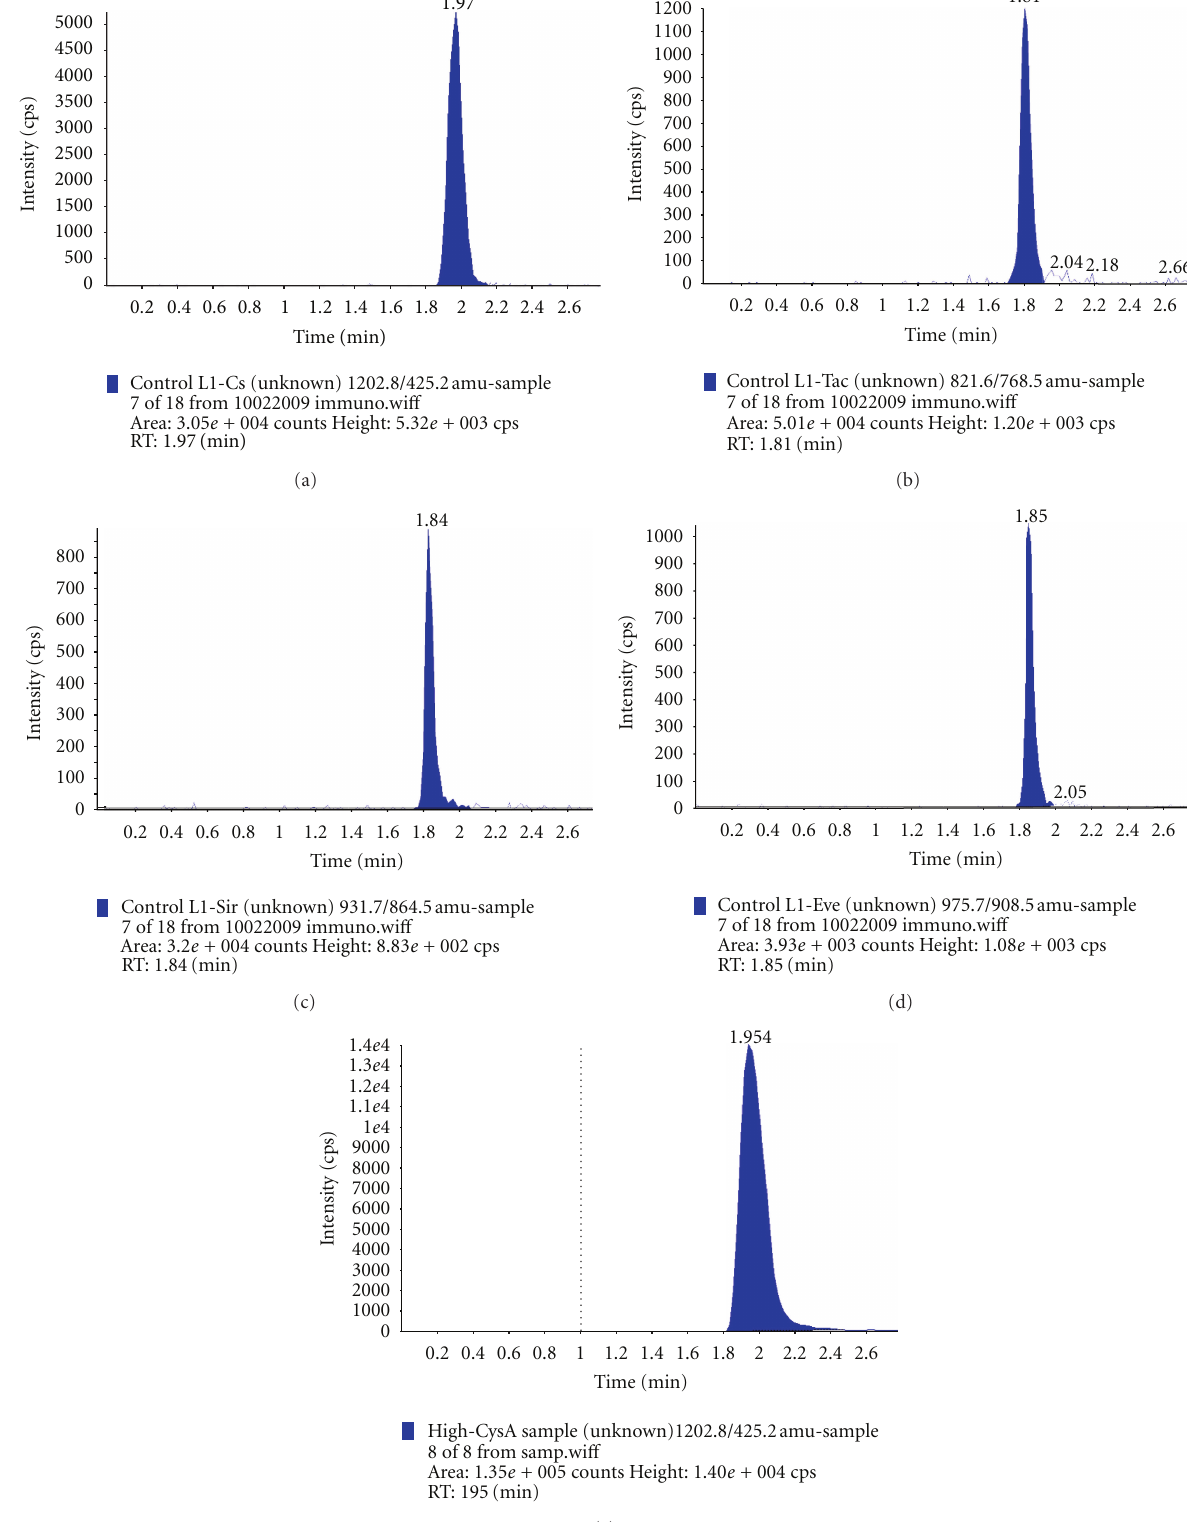
Figure 2: Extracted ion chromatograms of (a) cyclosporin A, (b) tacrolimus, (c) sirolimus, and (d) everolimus from whole blood control and (e) cyclosporin A from patient